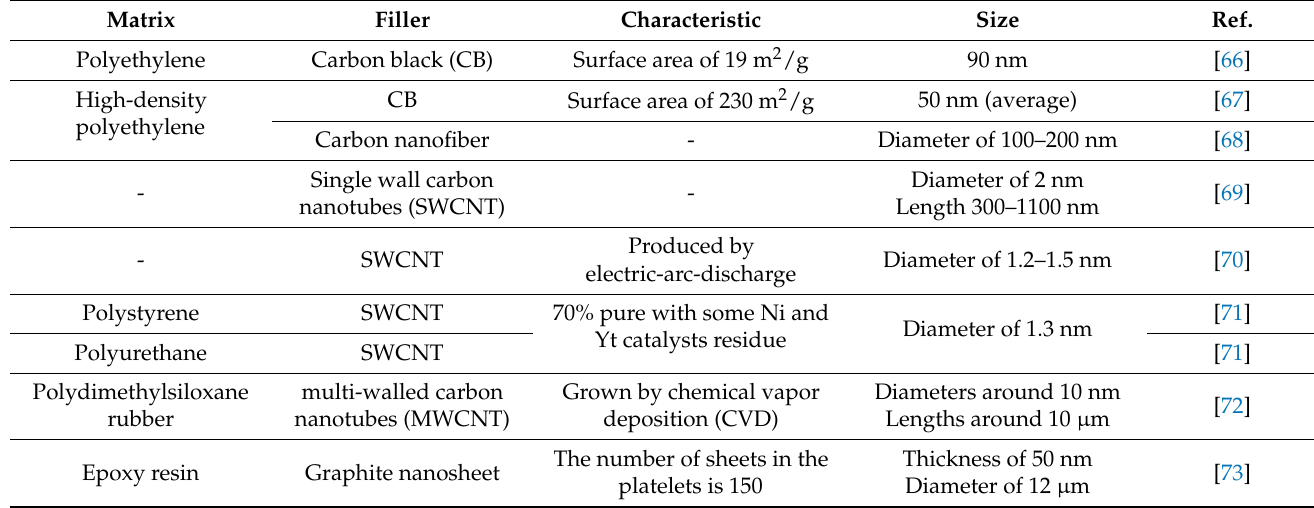
Table 3. Characteristics of carbon allotrope fillers used in nonlinear